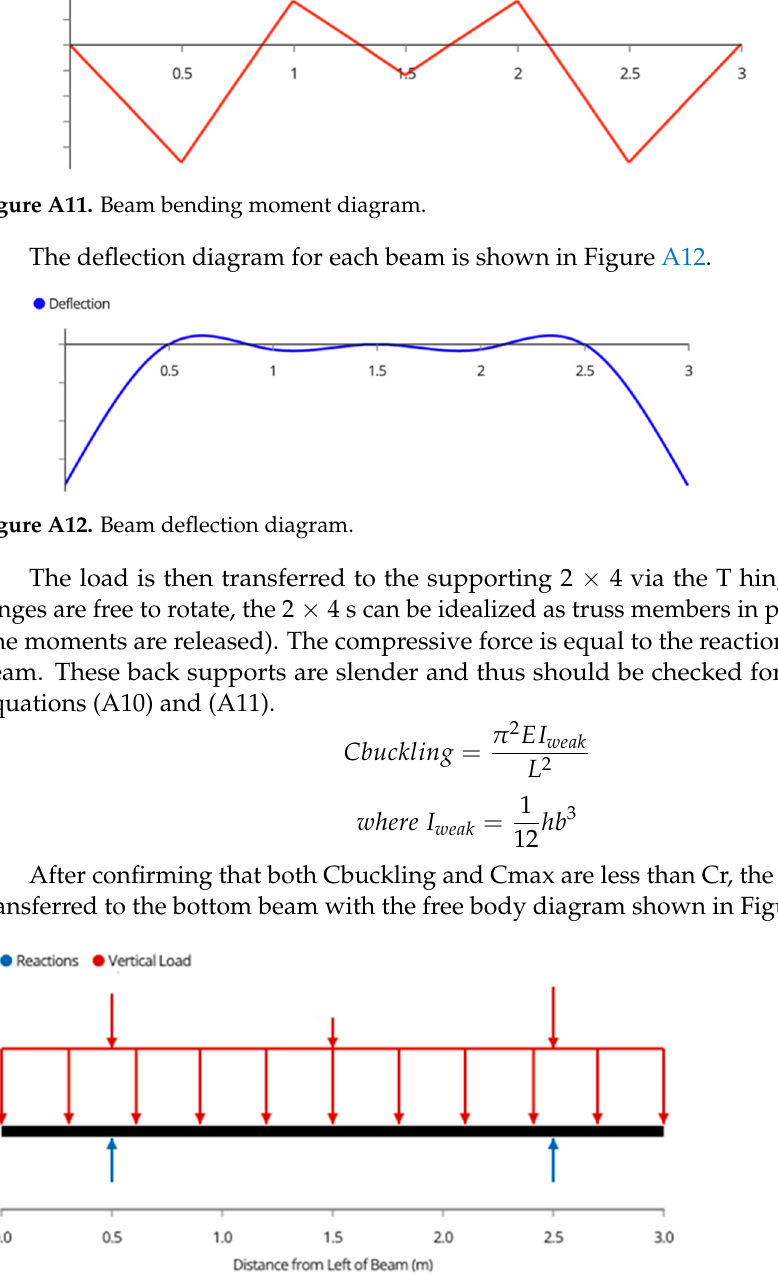
Figure A10. Beam shear force diagram. The bending moment diagram for each beam is shown in Figure A11.